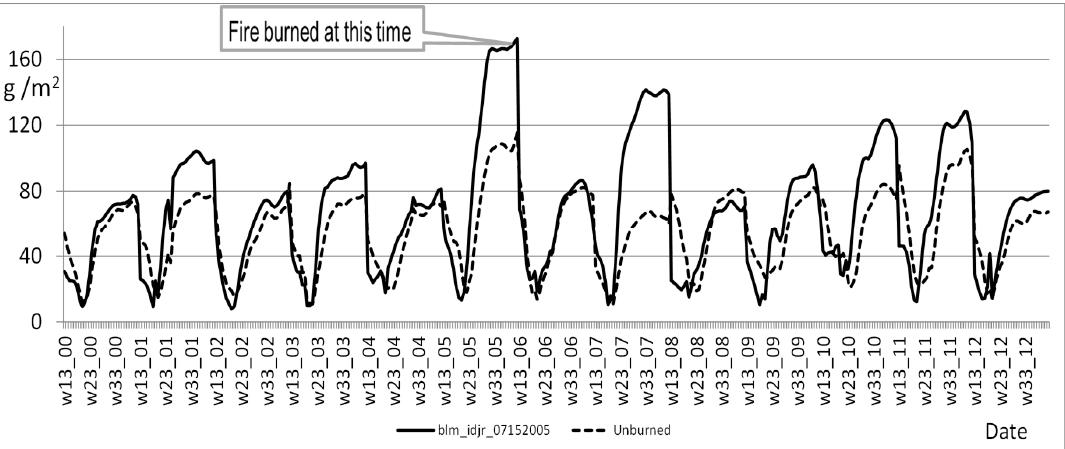
Figure 5. Dead biomass for a single burn area (burned on 15 July, 2005; solid line) versus mean biomass for sites that did not burn at any point during the 1984–2010 time frame (dashed line). Note that the burn area typically had higher biomass than the sites that did not burn throughout the entire time frame, with especially high values for the year that the site burned (as well as in 2007, when the site did not burn). The time axis represents the week of the year that biomass is estimated (e.g., w13_00 is the 13th week in 2000).